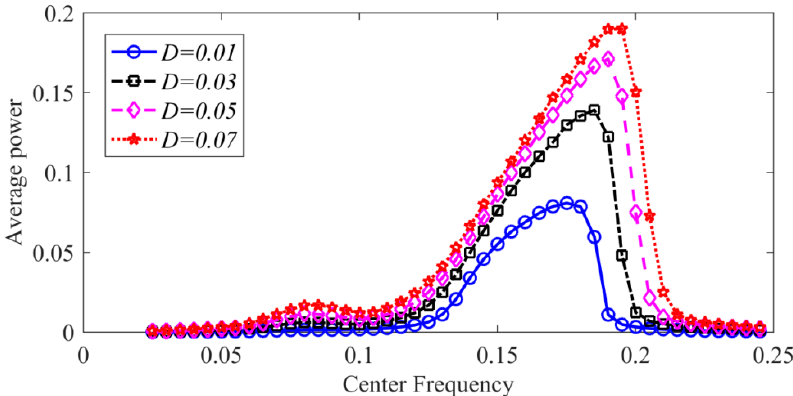
Figure 10. Influence of center frequency on the output performance of the asymmetric MEH excited by band-limited noise with different noise intensity ( Δ = 0.05).